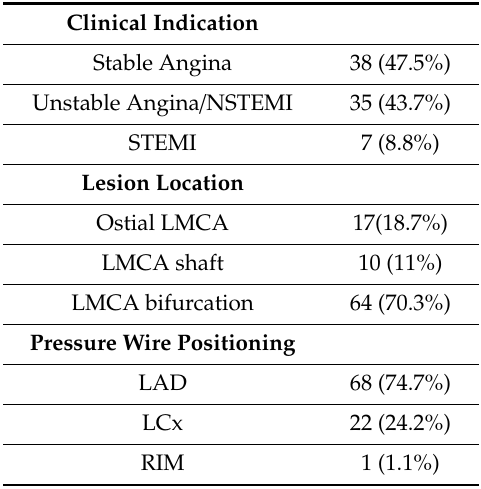
Table 2. Procedural characteristics.